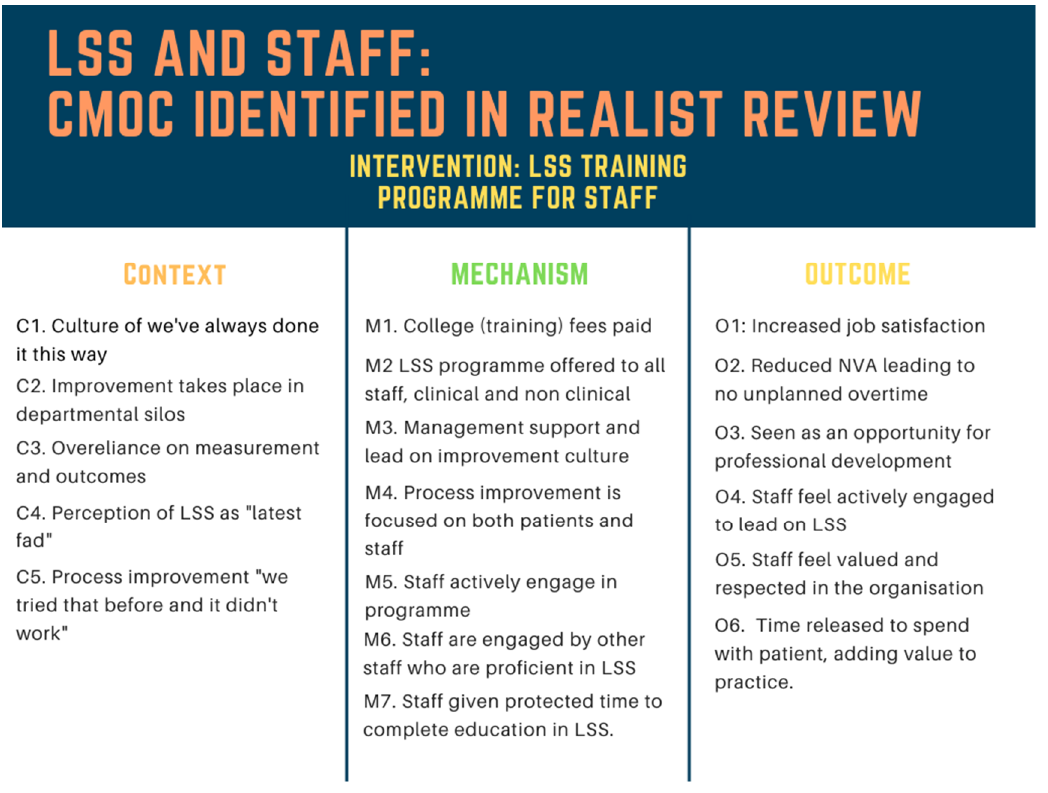
Figure 4. CMOc extracted from the realist review relating to LSS and staff.